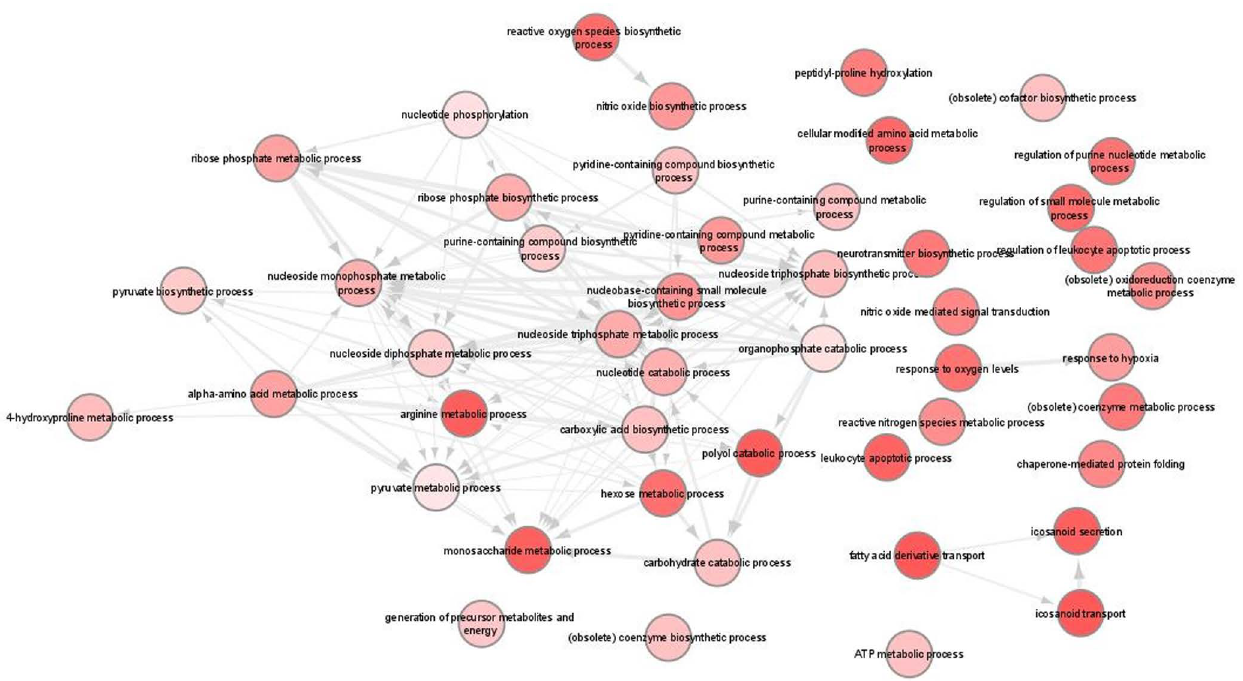
Figure 7. Gene ontology (GO) enrichment analysis in L. infantum infected BMDCs summarized by REVIGO. Graph shows biological processes enriched (parents GO terms) in upregulated genes (Benjamini-Hochberg p -value < 0.01). Highly similar GO terms are linked by edges. Bubble color indicates the user-provided p -value. GO terms that are highly similar are linked by edges in the graph, where the degree of similarity is indicated by the line width